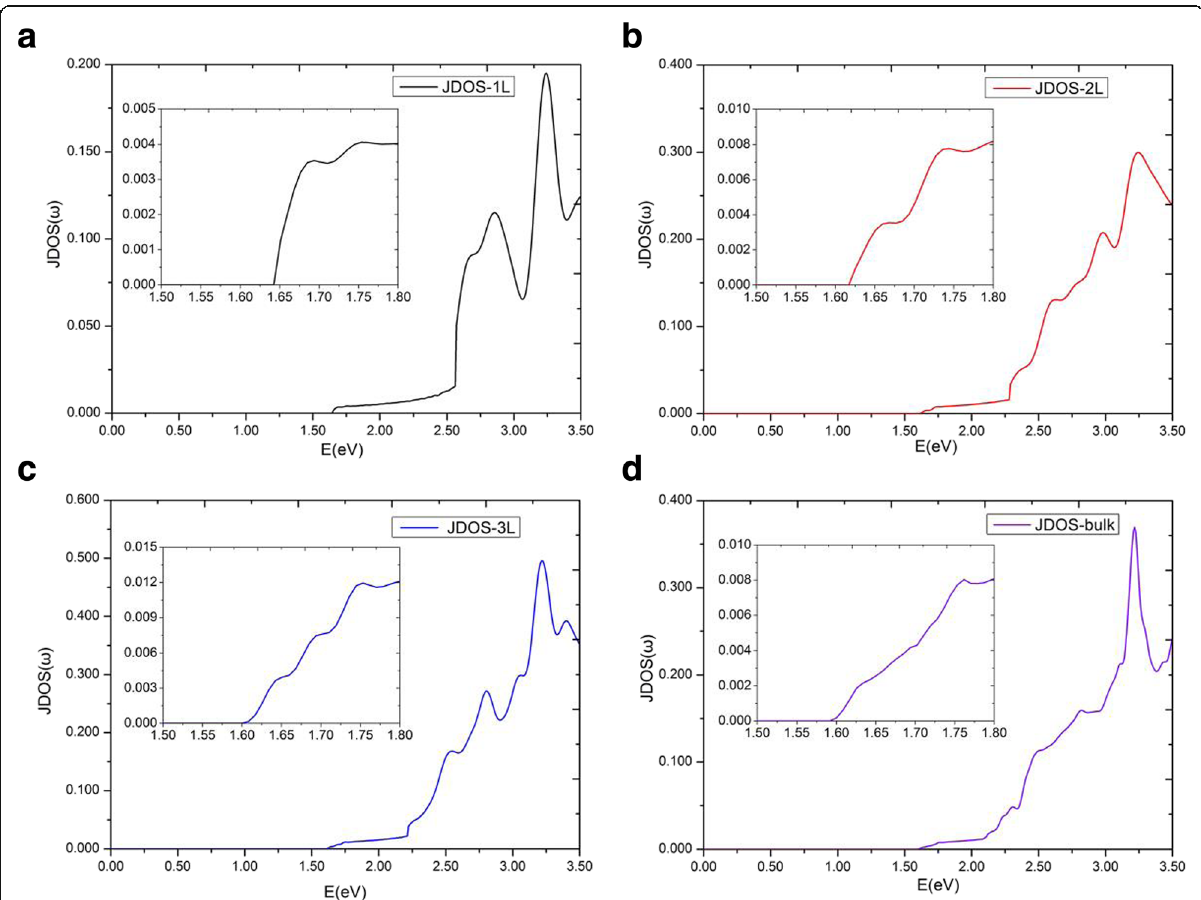
Fig. 7 Joint density of states for the monolayer, bilayer, trilayer, and bulk MoS